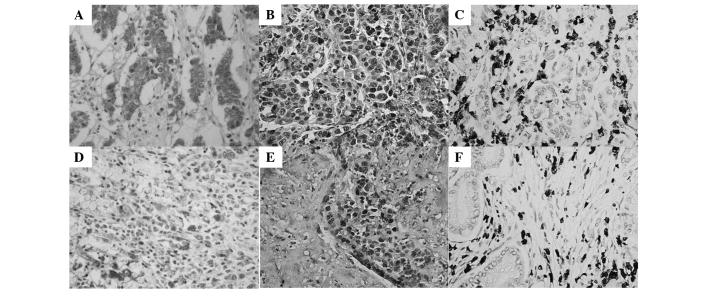
Expression of STAT3, p-STAT3 and HIF-1α in VM GAC and non-VM GAC tissues (hematoxylin and eosin stain; magnification, ×400). (A) STAT3, (B) p-STAT3 and (C) HIF-1α in VM GAC tissues. (D) STAT3, (E) p-STAT3 and (F) HIF-1α in non-VM GAC tissues. STAT3, signal transducer and activator of transcription-3; p-STAT3, phosphor-STAT3; HIF, hypoxia-inducible factor; VM, vasculogenic mimicry; GAC, gastric adenocarcinoma.